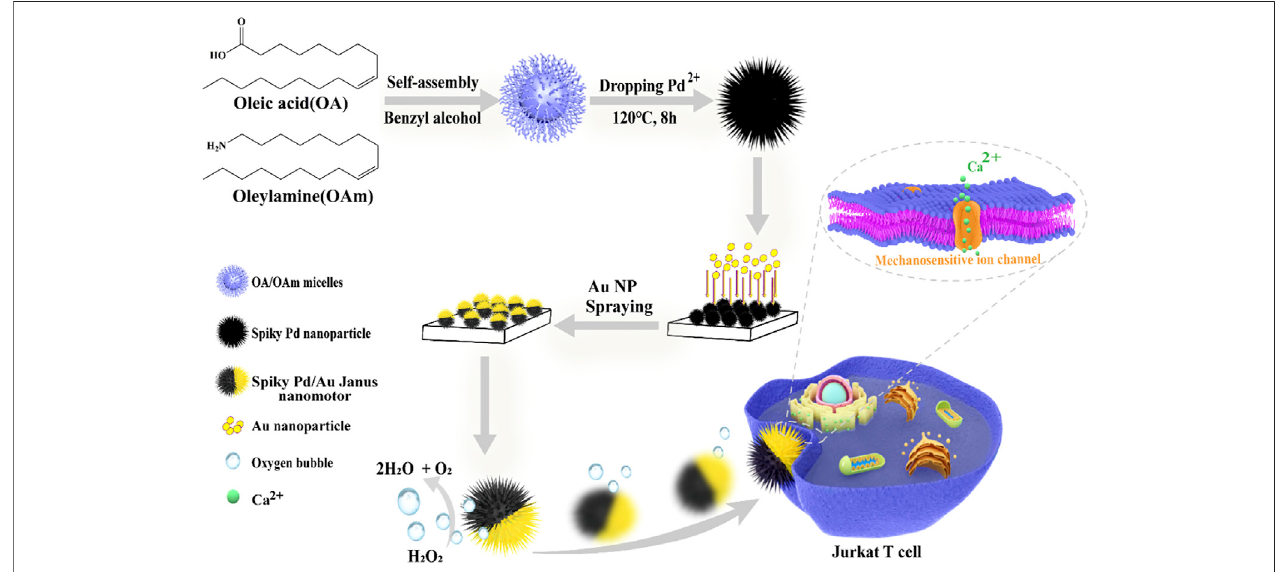
FIGURE1| SchematicillustrationoftheconstructionprocessofspikyPd/AuJanusnanomotorsandthefast-movingnanomotortriggersTcellactivationmediated by the professional mechanosensitive ion channels.